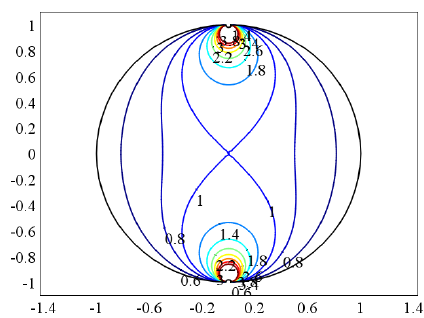
Figure 3. The normalized weight function of the single-phase flow.